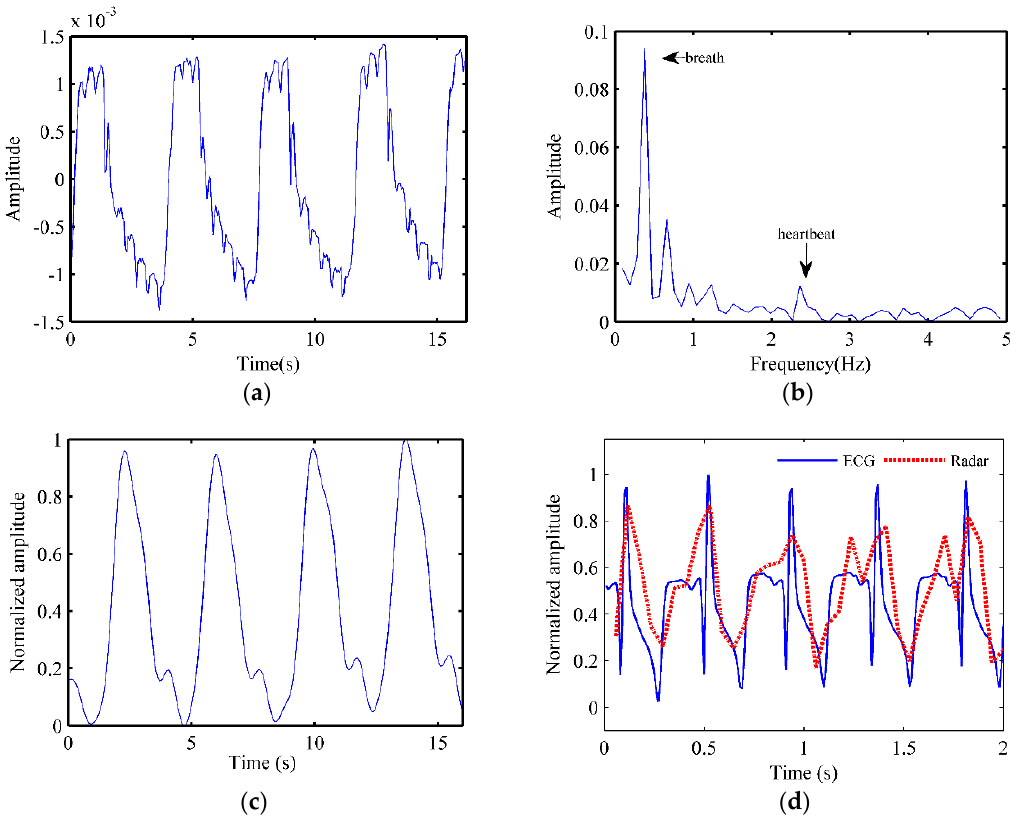
Figure 5. Experimental results. ( a ) The radar echo signal of the dog; ( b ) The spectrum of radar echo signal of the dog; ( c ) Breathing signal of the dog obtained by filtering; ( d ) Heartbeat signal received by radar and electrocardiogram (ECG), the inset shows waveform details at a selected 2-second